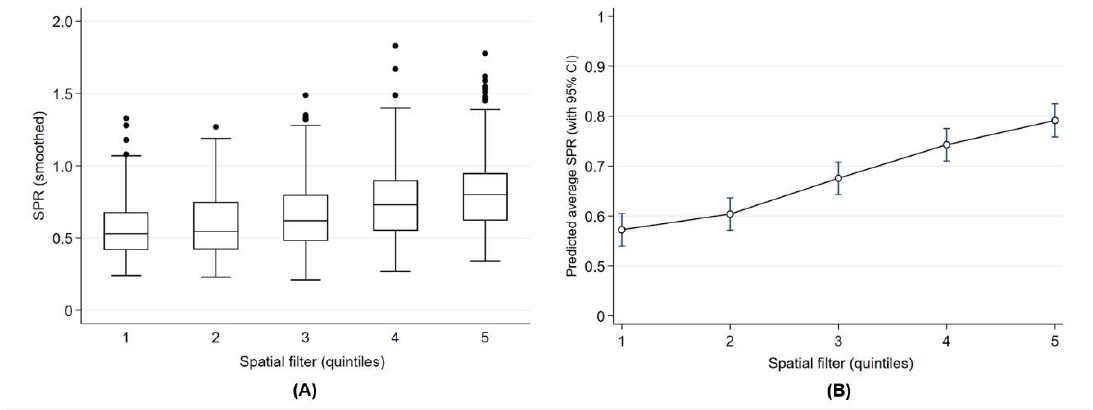
Figure 5. Geographic gradient of smoothed SPR ( A ) and predicted average of SPR ( B ) across Edmonton zones defined by the spatial filter quintiles.